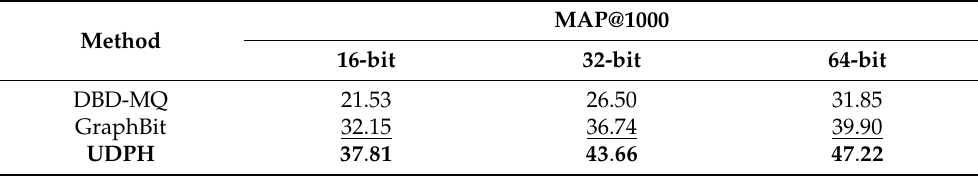
Table 2. Retrieval results (%) in terms of MAP@1000 on CIFAR-10 with AlexNet as the backbone. The results of DBD-MQ and GraphBit are directly copied from the publications. The best accuracy results are in bold and the second-best results are underlined.